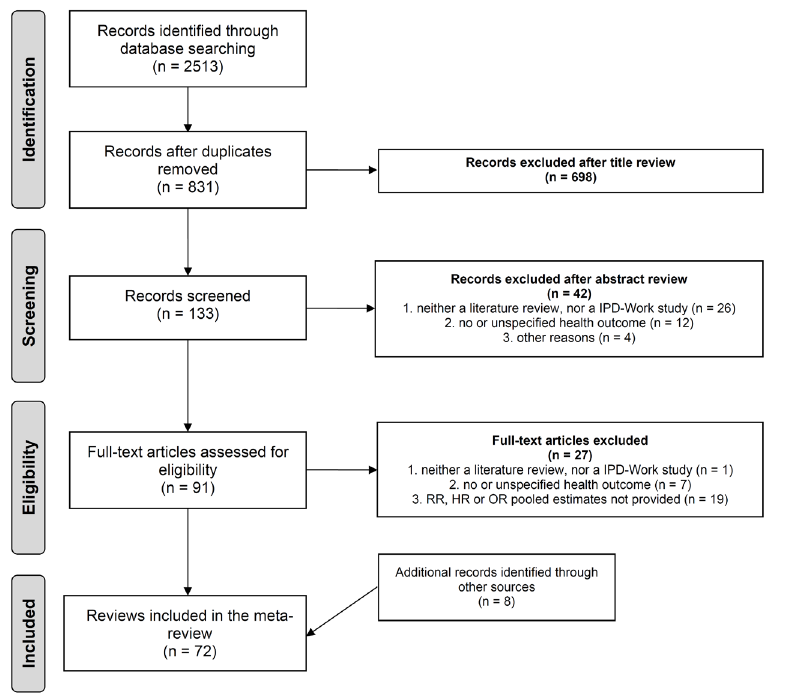
Figure 1. Selection process of